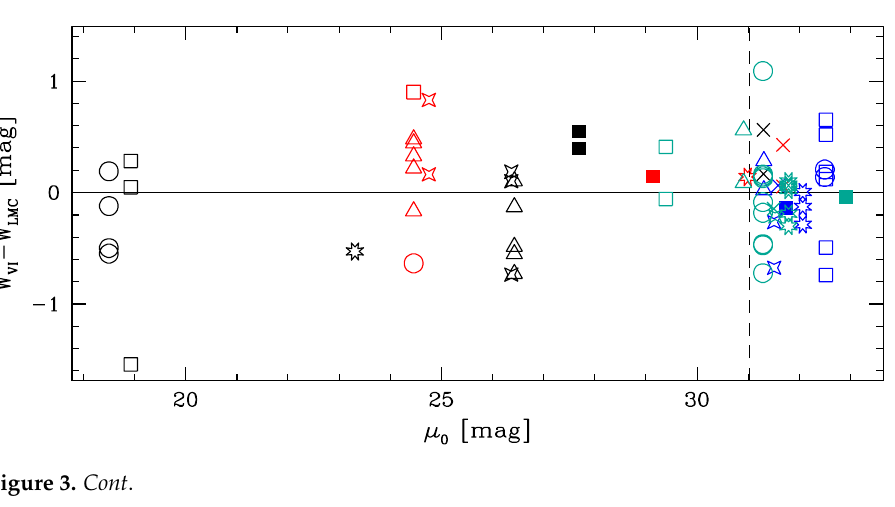
Figure 2. Upper panel: VI Wesenheit of the ULPs in Table 1 placed at the LMC distance. The black solid and dashed lines are the W VI relations by OGLE [21] and Bird et al. [9], respectively. The dashed and solid red lines and the blue line are the relations obtained by using all the ULPs, those with logP < 2.15 and only the SH0ES sample, respectively (see text for details). differences between the observational Wesenheit of the ULPs, W VI , and that obtained adopting the OGLE relation [21], W LMC , are plotted as a function of the logP . In both panels, the adopted symbols for the ULPs are the same as in Figure